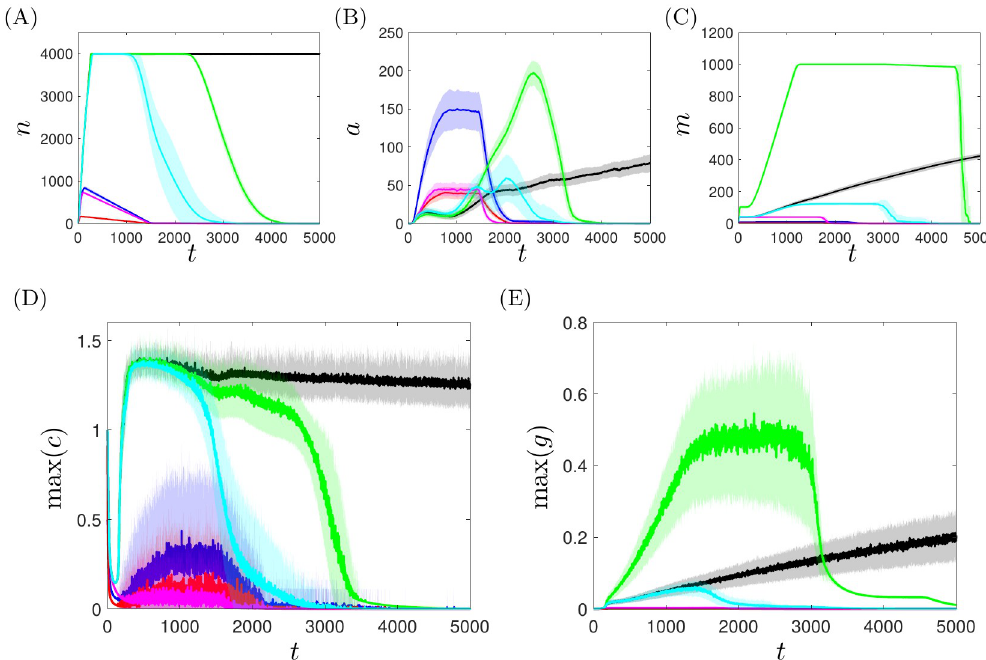
Fig 10. Simulations resulting in healthy, resolved outcomes for c 0 = 0.5 (blue), r = 5 (red), α mr = 0.25 (green), α ncr = 0.1 (magenta) and α = 0.0015 (cyan), with healthy choices of chemotaxis parameters ( k ngr parameters as in Table 1. The chronic inflammation of Fig 8 is shown in black. (A–C) Global cell counts for active neutrophils, apoptotic neutrophils and macrophages respectively. (D,E) Maximal concentrations of mediators c and g across the domain. Solid lines represent the mean result over 100 simulations of the model; shaded areas represent plus/minus one standard